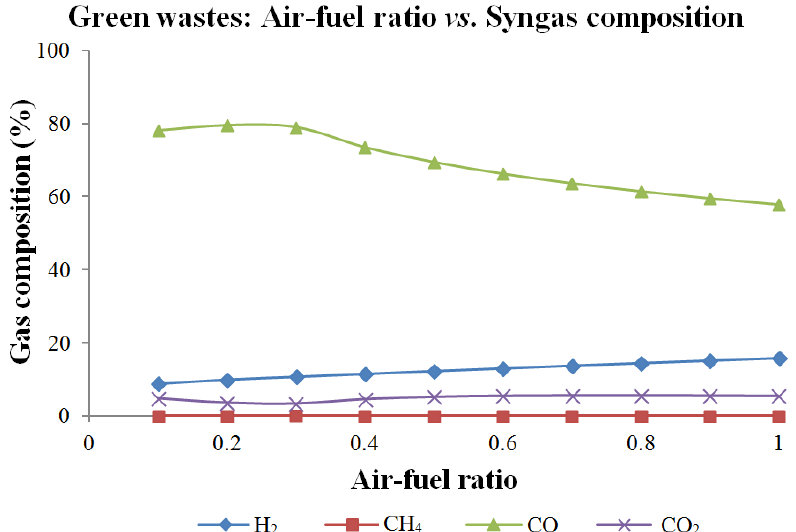
Figure 5. Effect of air-fuel ratio for green wastes (gasifier temperature: 700 °C).